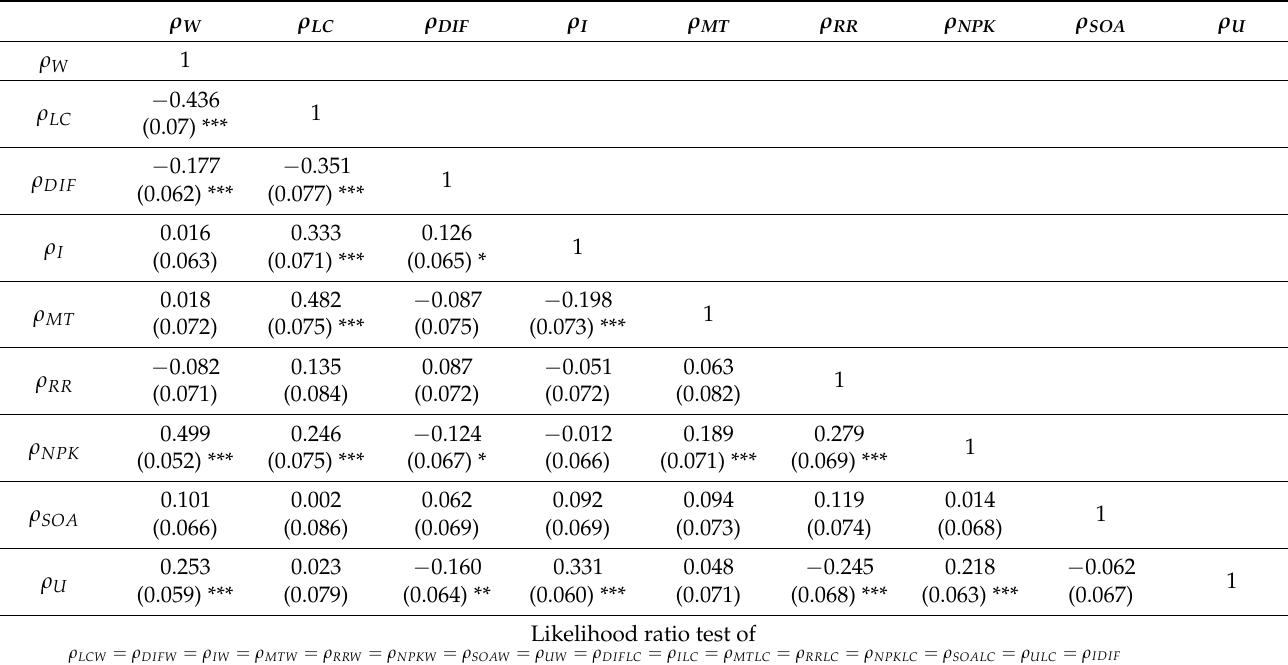
Table 4. Correlation matrix from the multivariate probit